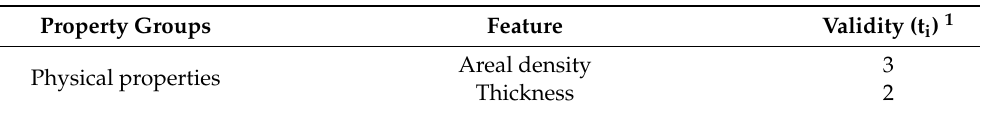
Table 4. Validity of the groups of soft and hard ballistic insert properties being the criteria for selection of the optimal insert